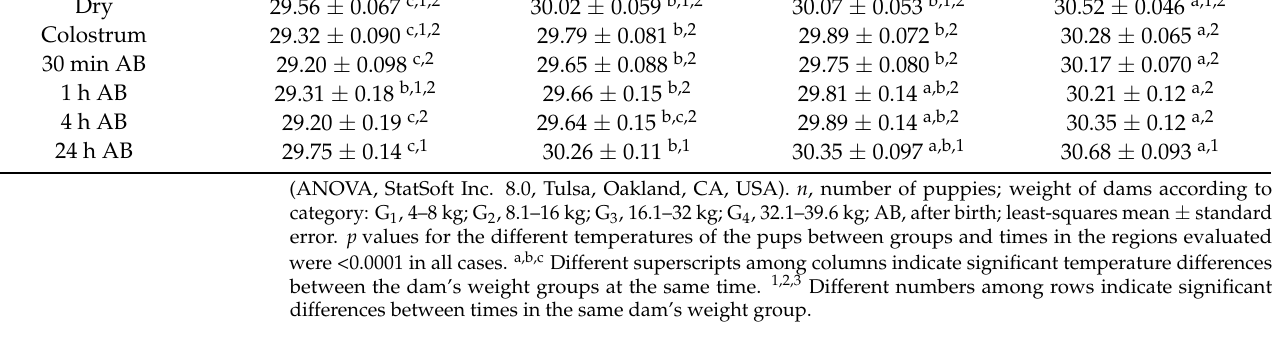
Table 8. Mean temperature ( ◦ C) of upper left palpebral (ULP) window at different times in newborn puppies from bitches classified into 4 groups according to its